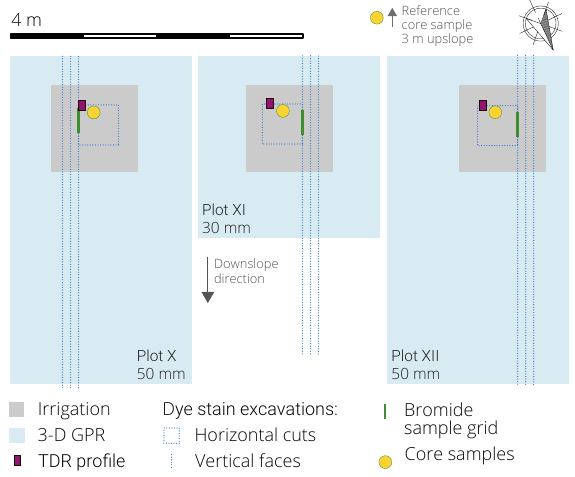
Figure 2. Plan view layout of the plot-scale irrigation experiments. Three irrigation plots (1m 2 , gray squares) are monitored by 3- D time-lapse GPR (blue rectangles) and TDR (soil moisture tube probe, red box). The plots are sampled for tracer recovery by per- cussion drilled core samples (yellow dot) and in a grid on the last of three vertical faces (dashed blue line). Moreover, dye stains are ex- cavated at horizontal cuts in the center of the irrigation area (dashed blue square). A pre-irrigation reference for porewater stable isotope composition is sampled as a fourth core 3m